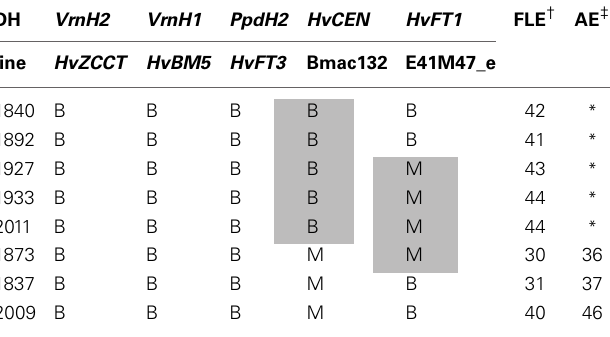
Table 2 | Haplotypes for major flowering time genes and markers closest to QTLs (see Cuesta-Marcos et al., 2008) for selected doubled haploid (DH) lines of the population Beka × Mogador.